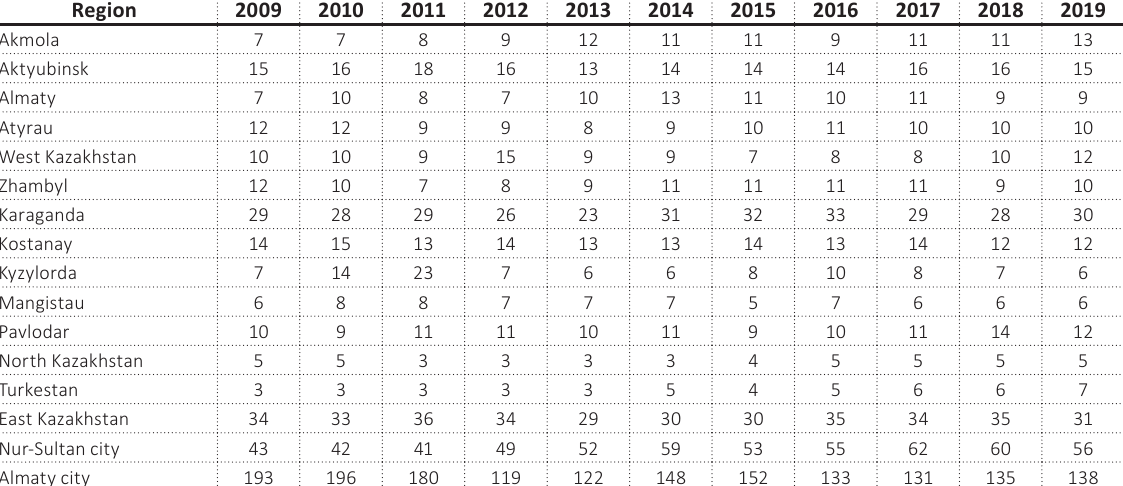
Source: Bureau of National Statistics